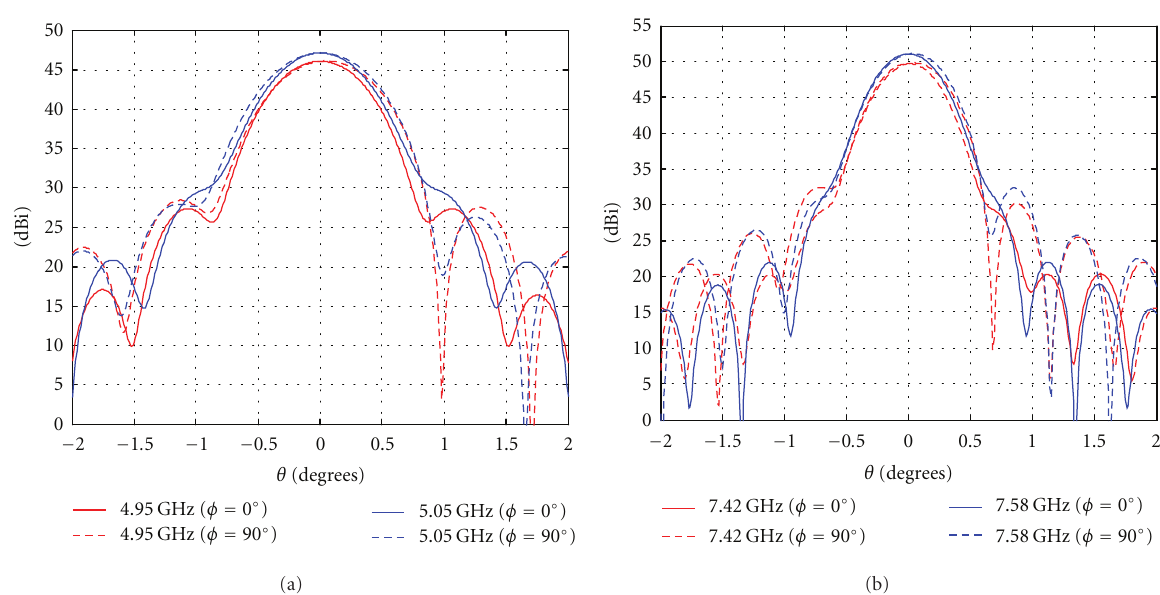
Figure 25: Reflector antenna radiation patterns with the EBG dual band at f L (a) and f H